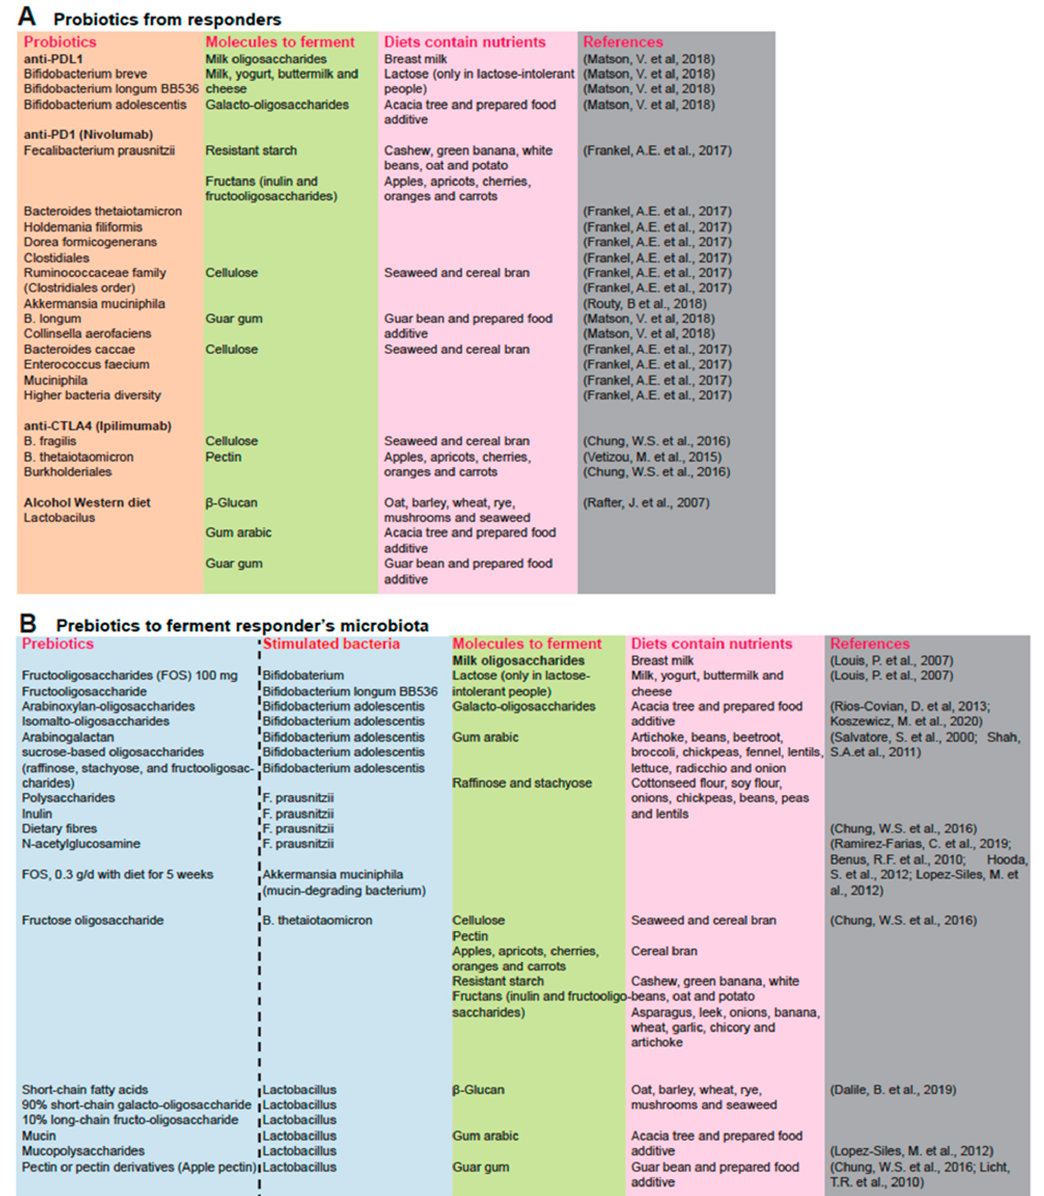
Figure 2. Probiotics and prebiotics fermented by beneficial bacteria for immune checkpoint inhibitors. ( A ) Bacterial species that are positively associated with PD-1 and PD-L1 blockade therapy are summarized. Responders for immunotherapy have specific gut microbiota. Bacteria species are summarized in a table from the literature [20,79–105]. ( B ) Bacterial species and prebiotics that are positively associated with PD-1 and PD-L1 blockade therapy are summarized.